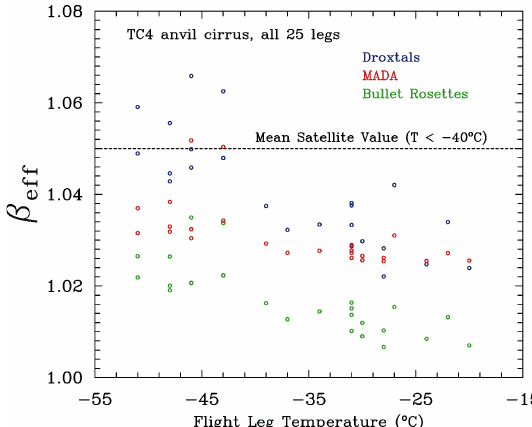
Fig. 12. Calculations of β eff from TC4 in situ measurements of fresh anvil cirrus using two ice optics schemes: MADA and Yang et al. (2005) (i.e., droxtals and bullet rosettes). The satellite-retrieved mean value of β eff , based on this study for T < − 40 ◦ C, is shown by the dashed line. A direct comparison between retrieved and mea- sured β eff can be made for T < − 40 ◦ C, suggesting quasi-spherical particles (i.e., droxtals) dominate, which was validated via in situ